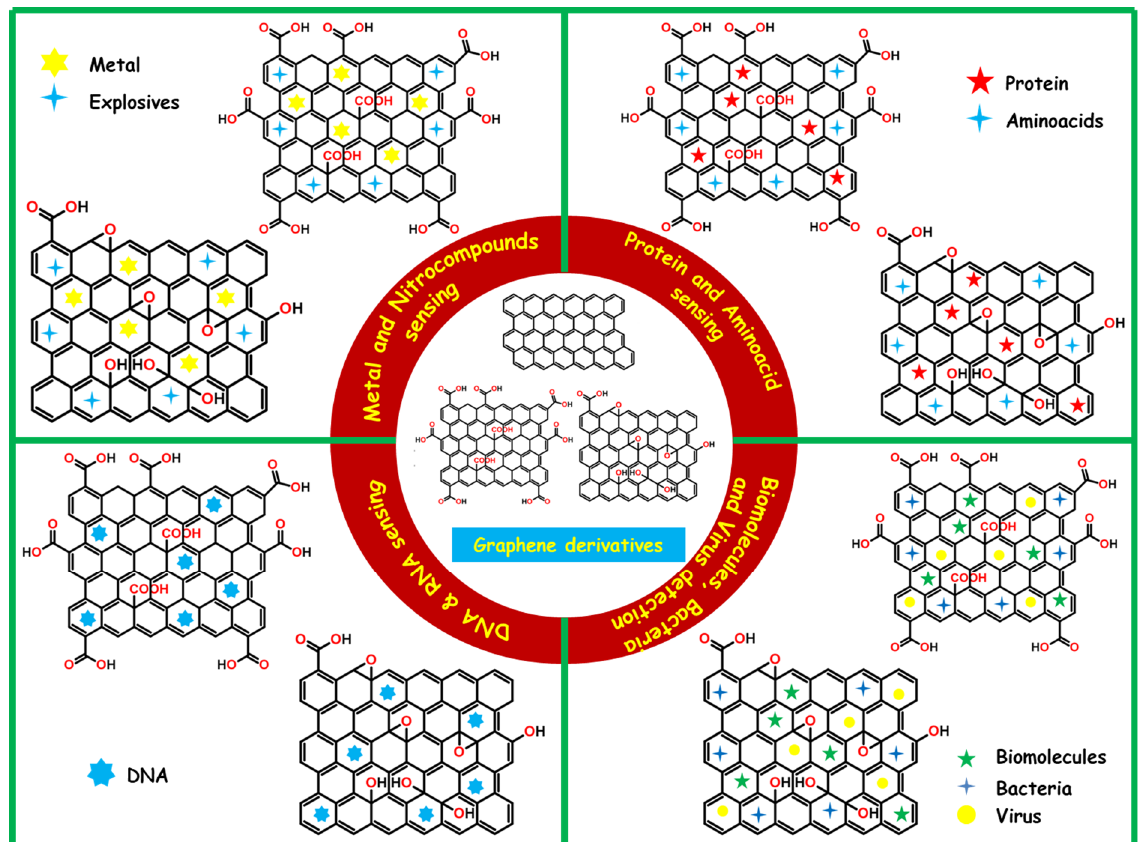
Scheme 1. Graphical representation of the graphene-based nanomaterial design strategy and its sensing of various target analytes. sensing of various target analytes.